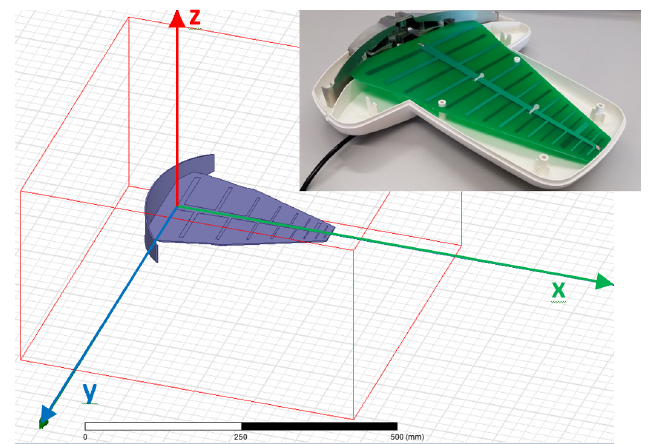
Figure 5. Televés 4G NOVA antenna.